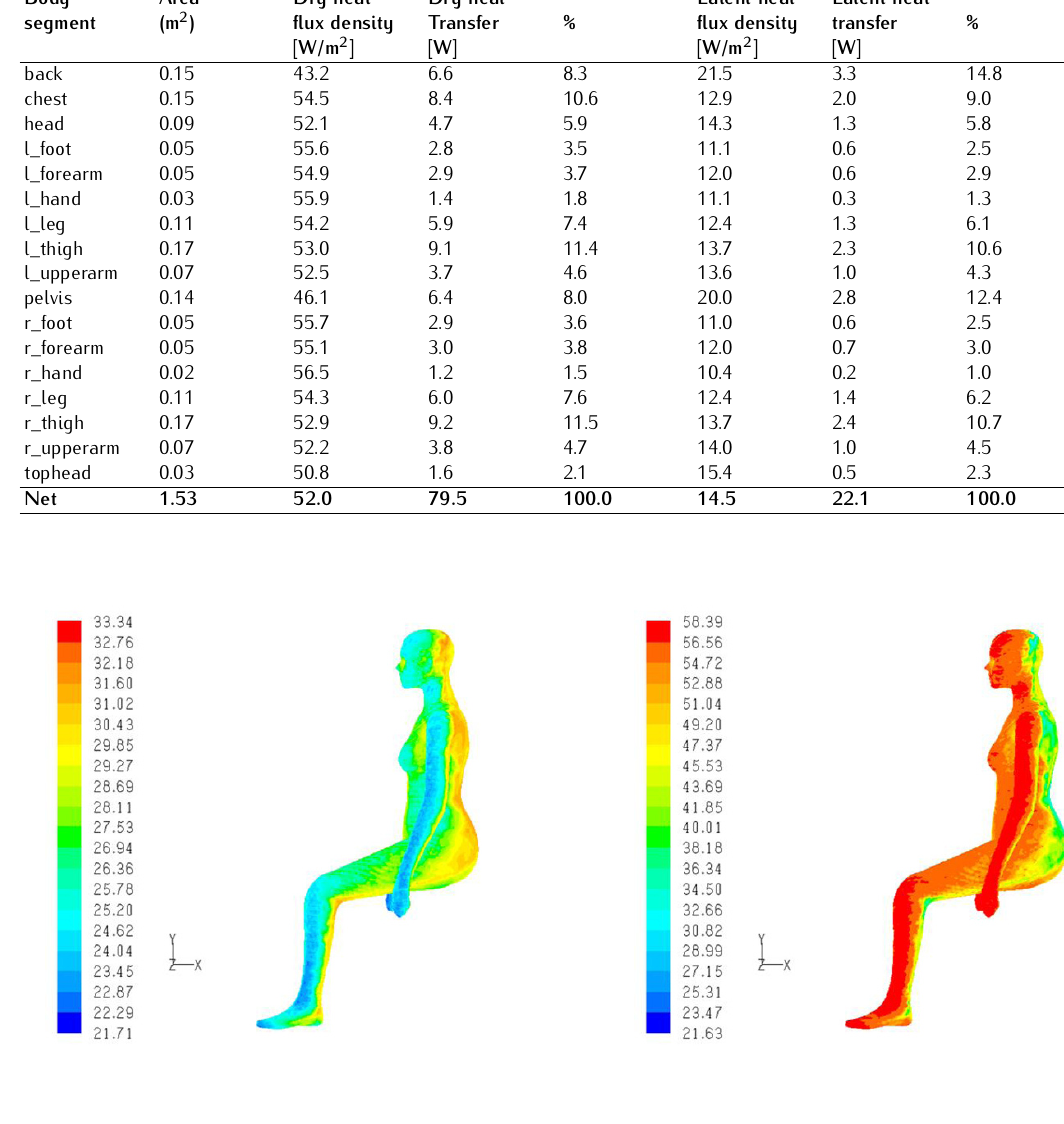
Figure 7. Temperature distribution over the clothed body [ ◦ C].